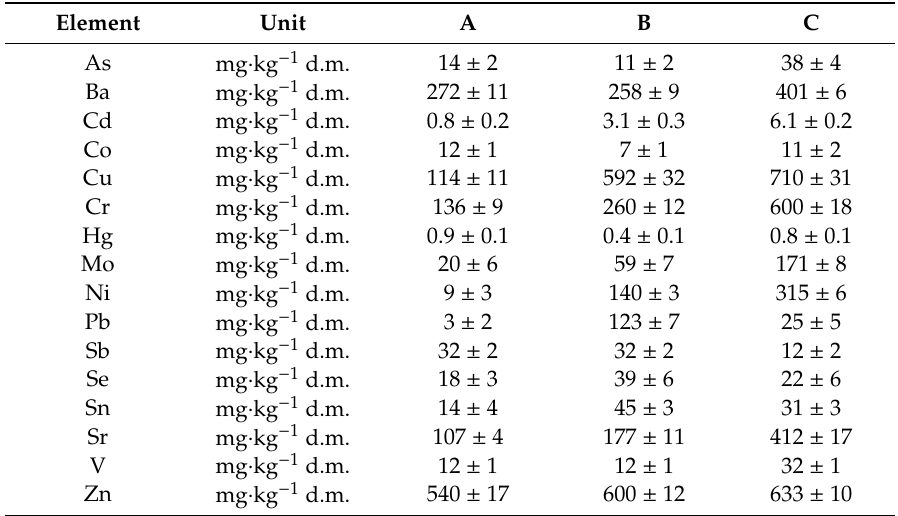
Table 2. Chemical characterization of alternative fuels (own